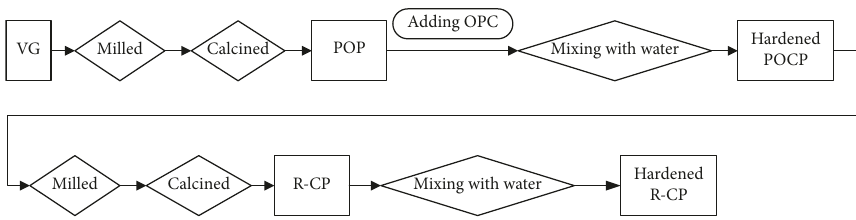
Figure 2: The flowchart of preparing R-CP and its hardened R-CP.